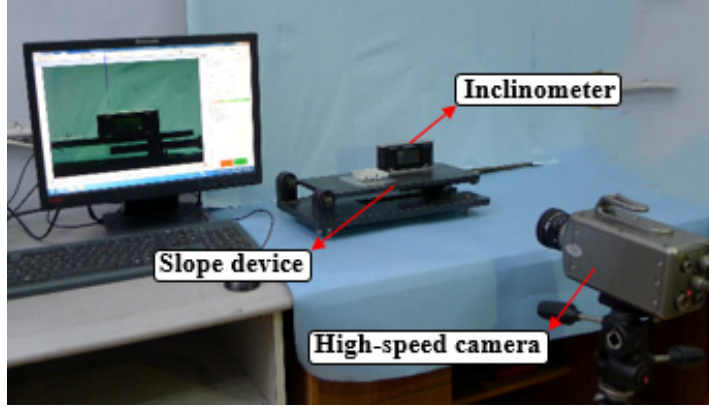
Figure 12. Device for the measurement of the coefficient of static friction.